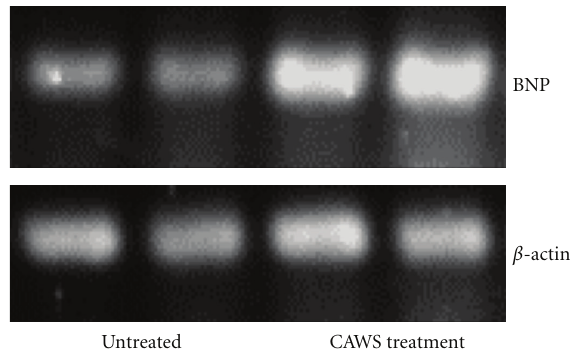
Figure 7: mRNA expression of murine BNP in CAWS arteritis. The cDNA levels of murine BNP were examined by RT-PCR and found to be